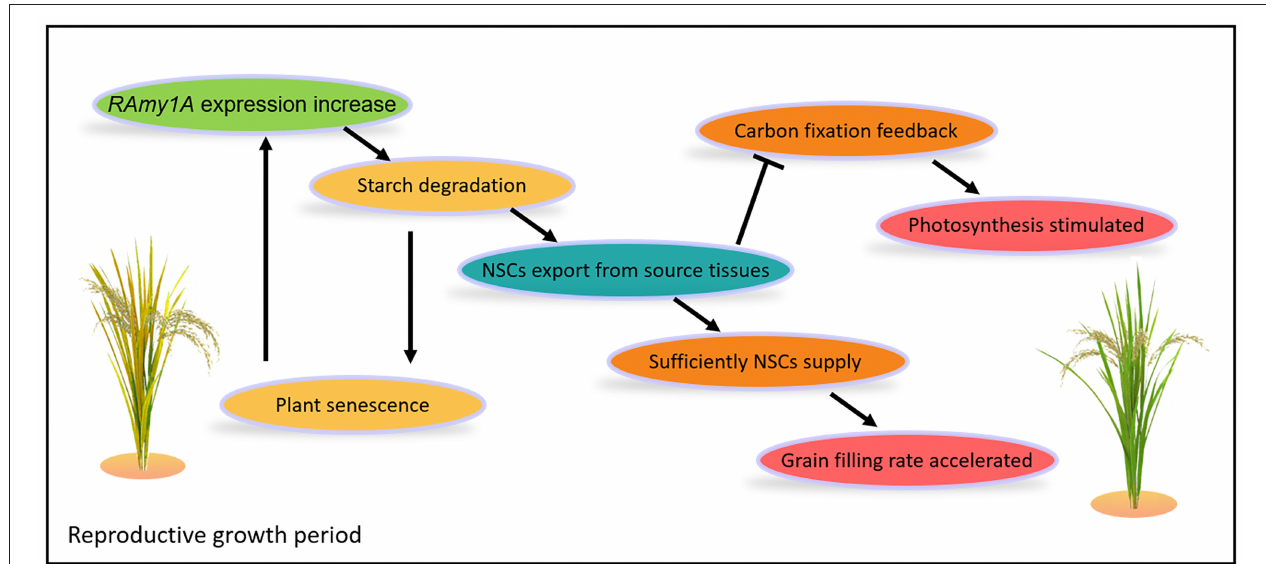
FIGURE 6 | A hypothetical schematic diagram for the physiological processes of transgenic rice during the reproductive growth period. During the reproductive growth stage of transgenic rice, the expression level of RAmy1A gene was increased driven by pSAG12 . This caused starch degradation, and the export of NSCs from the source tissues to fuel the grain filling process, thus leading to an accelerated grain-filling rate. In contrast, the exportation of NSCs decreased the negative sugar feedback on carbon fixation, resulting in a higher Pn. Plant senescence associated with starch degradation may stimulate pSAG12 and further increase RAmy1a